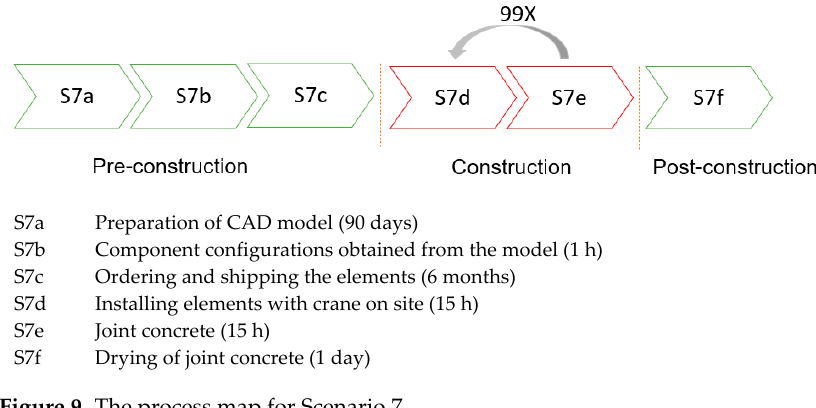
Figure 8. The process map of Scenario 6.